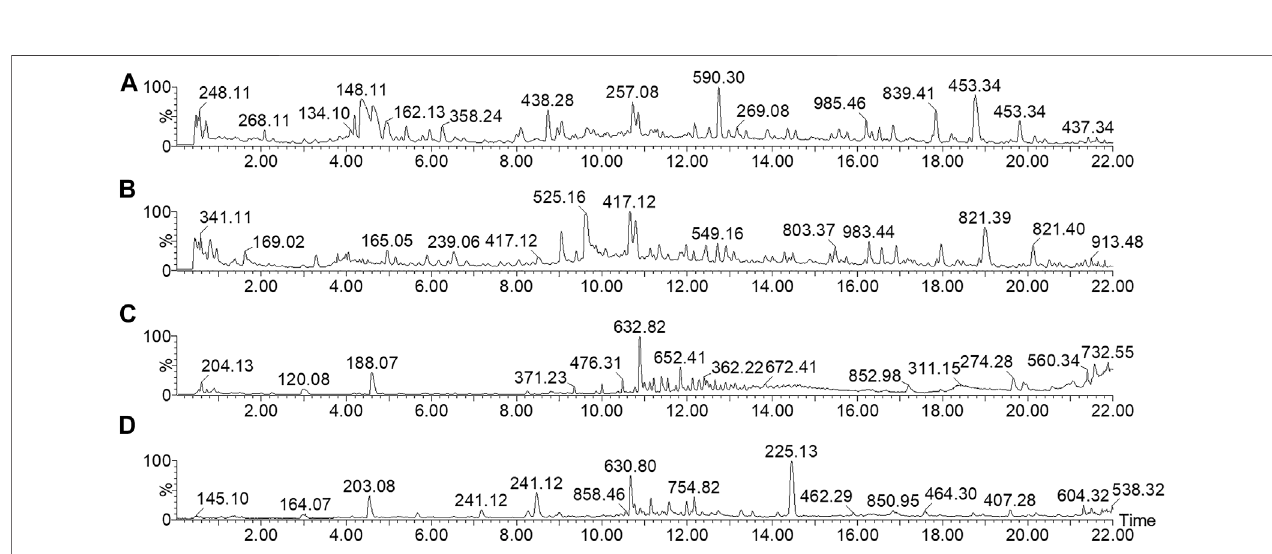
FIGURE 7 | TIC spectrum of chemical pro fi le and absorbed components from wutou decoction. (A , B) The chemical pro fi le of wutou decoction in ESI + and ESI − , respectively (C , D) The blood components of wutou decoction in ESI + and ESI − , respectively.